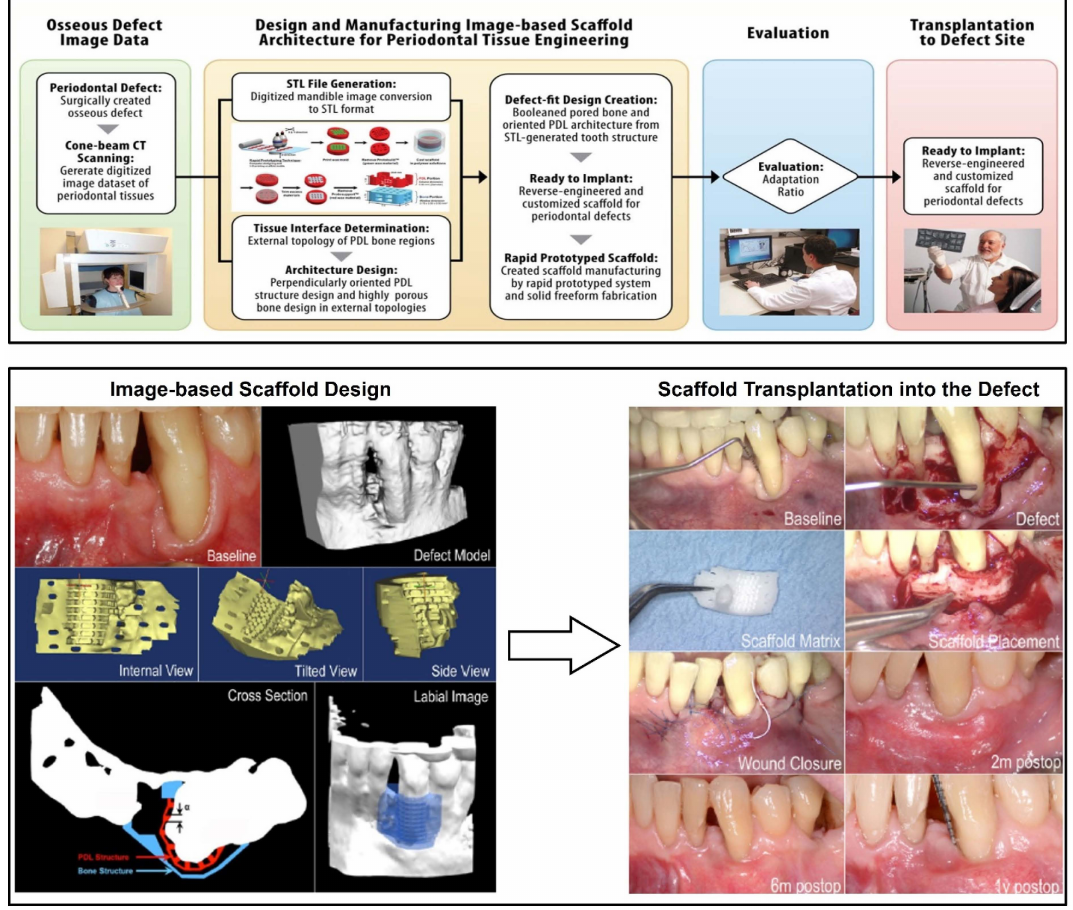
Figure 7. Flow chart for the design of customized, fiber-guiding scaffolds and clinical transplant of the 3-D printed, fiber-guiding scaffold to a labial defect. After the computer design of the customized scaffold, a 3-D printer was used to manufacture the PCL scaffolds. After pre-operative treatments, the PCL scaffold was placed at the defect with poly-D and L-lactic acid pins to secure the scaffold. The implanted site showed no signs of inflammation or infection during the first year after treatment